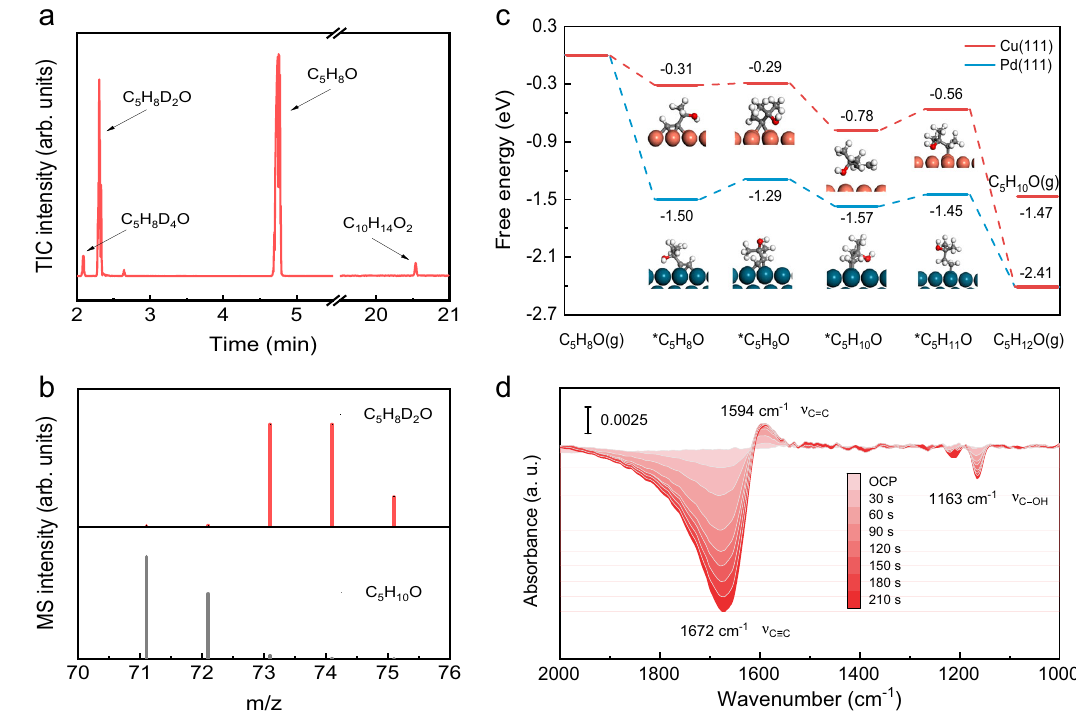
Fig. 3 | Theoretical and experimental investigations on the reaction mechan- ism. a Total ion chromatogram (TIC) of the liquid products in the D isotope labelling experiment. b Mass fragmentation patterns (red bars) were acquired at a 2.3min retention time of the TIC in Fig. 3a. For comparison, a reference fragmen- tation pattern of C 5 H 10 O (MBY) (grey bars) is displayed. c Free energy diagrams of